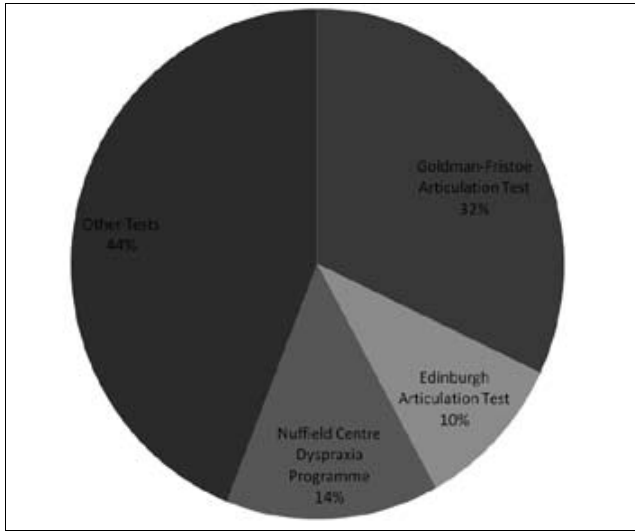
Fig. 3. Formal assessments of children’s speech used by participants.